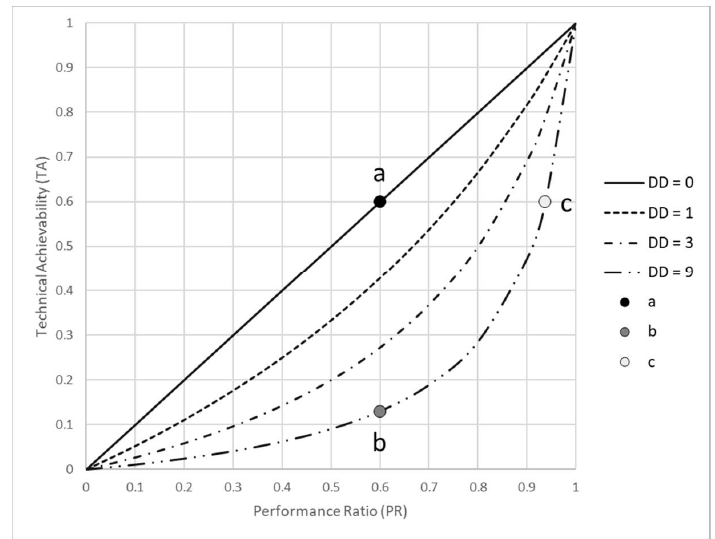
Figure 4. Technical Achievability.